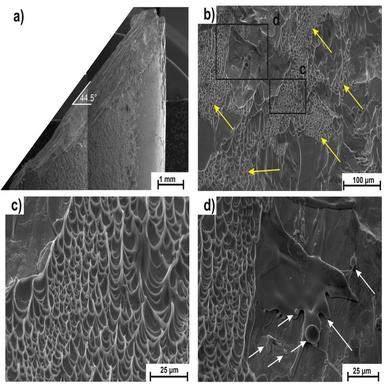
Fracture surface after compression test. (a) The fracture angle is inclined by around 45° with respect to the compression direction, which is typical for BMGs. (b) Vein-like patterns on the fracture surface, indicating significant softening upon fracture. (c) Higher-magnification image of the area c in (b), detailing a vein-like pattern, and (d) higher-magnification image of the area d in (b), showing droplets (as marked by arrows).